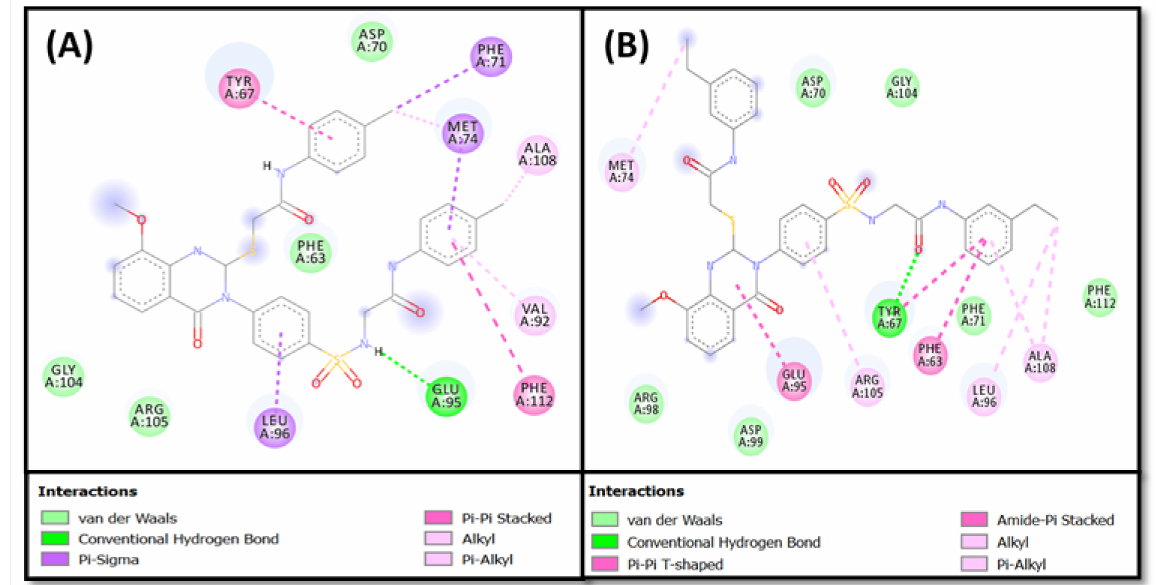
Figure 9. Molecular docking and interaction of ( A ) compound 4d , and ( B ) compound 4f , with the Bcl-2